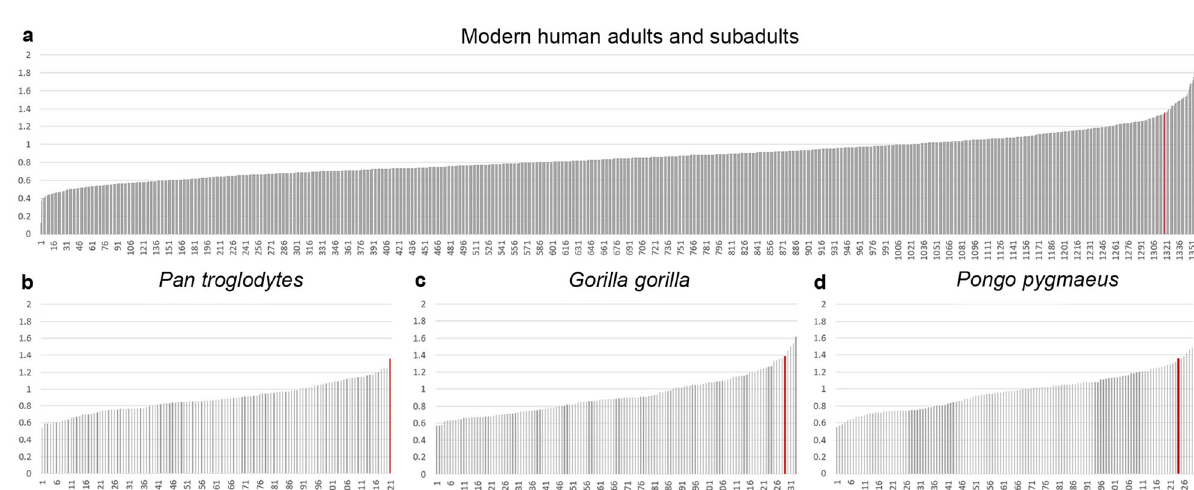
Fig. 4 Column distribution of the male – female pairwise Procrustes distances after Procrustes fi t based on 13 landmarks on the fi rst sacral vertebra. The red lines indicate the Procrustes distance between Sts 14 and StW 431. a In modern humans only 35 out of 1353 Procrustes distances (2.6%) exceeded that between Sts 14 and StW 431. b In Pan troglodytes 0% (0 out of 120) distances exceeded that between the fossils, c in Gorilla gorilla 4.5% (6 out of 132), and d in Pongo pygmaeus 3.9% (5 out of